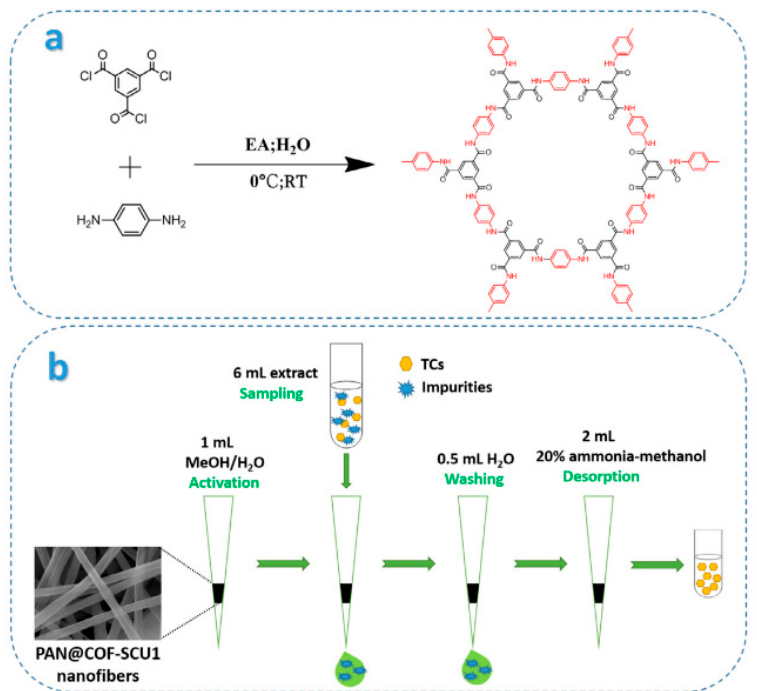
Figure 8. Schematic diagrams of ( a ) preparation of COF-SCU1 and ( b ) PT-SPE procedure for the extraction of TCs. Reprinted with permission from Ref. [94]. Copyright (2020) Elsevier.